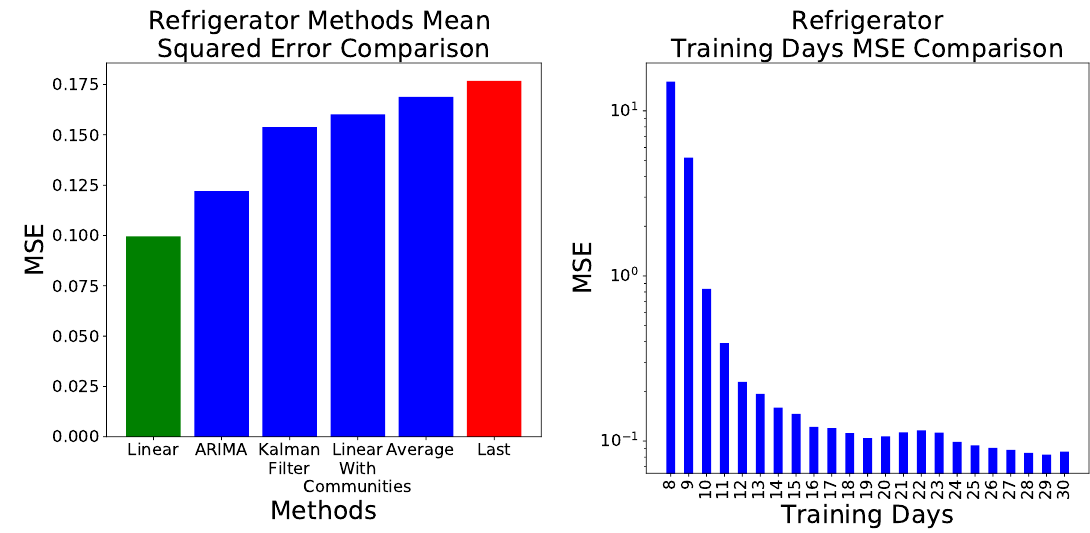
Figure 4. ( Left ) Error, measures as MSE , obtained by the six considered forecasting methods, when applied to the refrigerator’s temperature data set. The red and green bars respectively indicate the worst and best prediction models. ( Right ) Evolution of the MSE , as obtained by the linear model, as a function of the number of days used in the